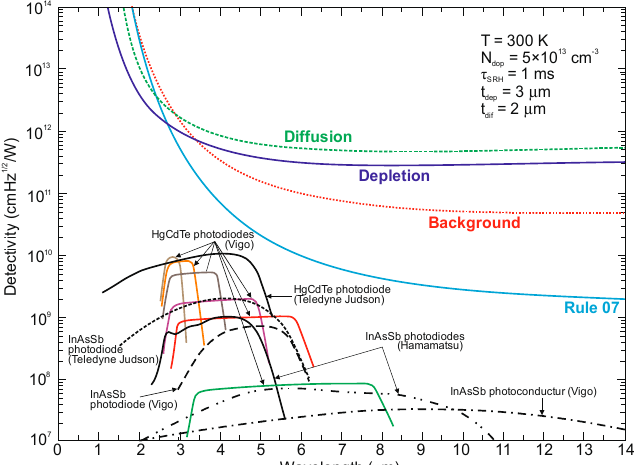
Figure 44. Detectivity on wavelength dependence for the commercially available room-temperature